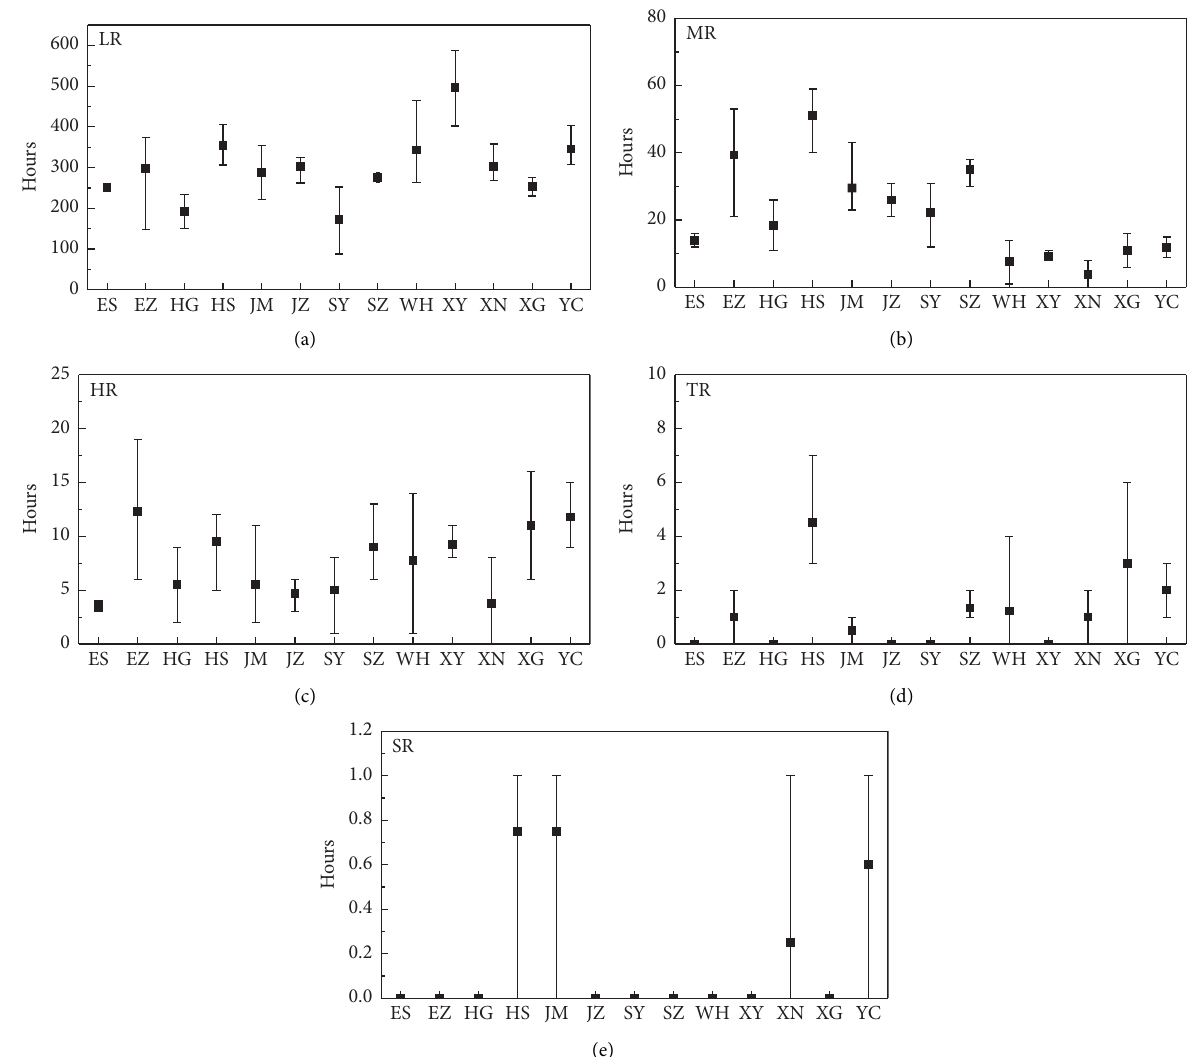
Figure 3: Distributions of precipitation hours at different levels during pollution days in Hubei Province from 2015 to 2017: (a) rainfall intensity < 1.5mm/h; (b) 1.5mm/h ≤ rainfall intensity < 3.5 mm/h; (c) 3.5 mm/h ≤ rainfall intensity < 8.0mm/h; (d) 8.0 mm/h ≤ rainfall intensity < 20.0mm/h; (e) 20.0mm/h ≤ rainfall intensity <